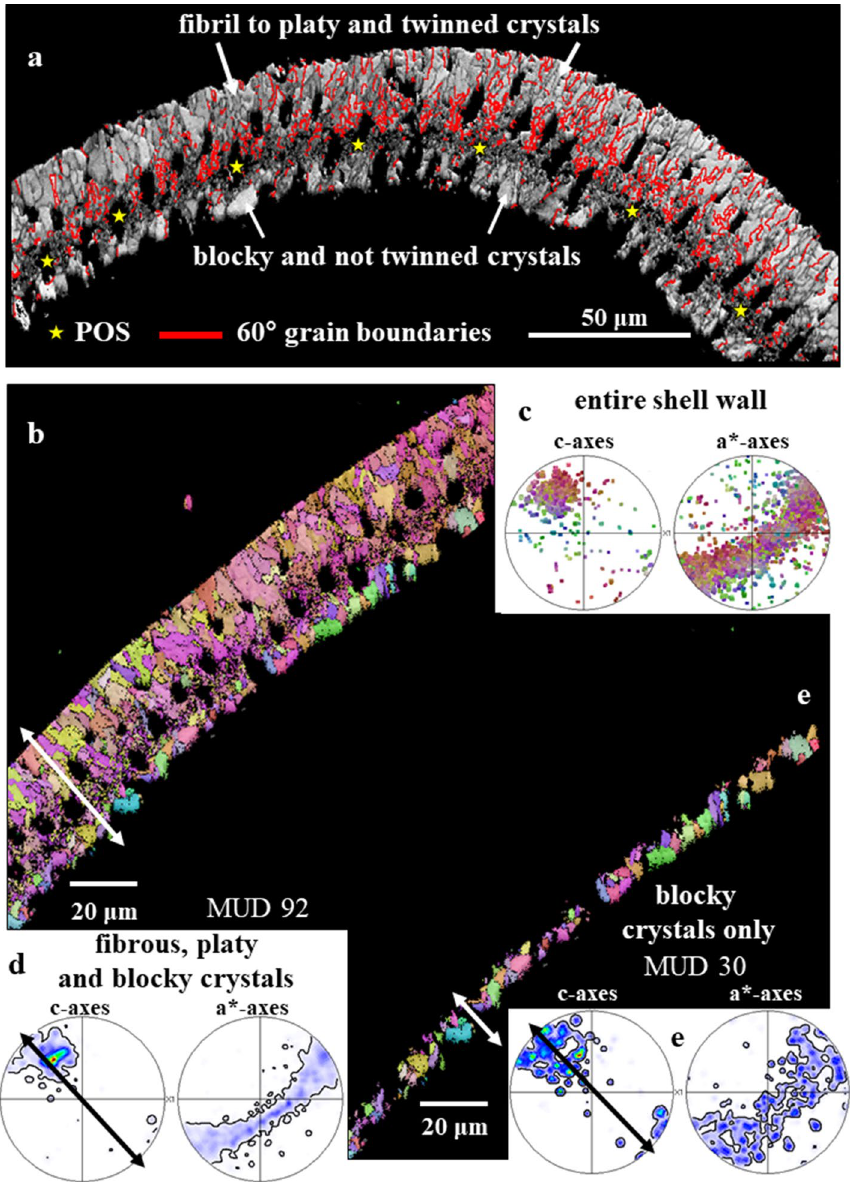
Figure 10. Structural characteristics of crystals and crystal assemblies on the two sides of the POS in Pulleniatina obliquiloculata shells. ( a ) EBSD band contrast measurement, with the distribution of 60° grain boundaries superimposed as red lines. ( b ) and ( e ) crystal orientation maps and ( d ) and ( f ) corresponding pole figures. Illustration of structural characteristics of the crystals and crystal units on the two sides of the POS: (1) fibril to platy crystal assemblages that are twinned ( b ) and (2) blocky, crystals that are not twinned ( e ). Blocky and fibril/fibrous-platy crystal assemblies have similar preferred orientation texture ( d , f ), they are, however, different in microstructure and crystal co-orientation strength. The blocky crystals are slightly less well co-oriented compared to the fibrous/platy crystals. Calcite c-axes are perpendicular to the shell surface for both the blocky as well as the fibril/platy crystal assemblages (white and black arrows in ( b ), ( d ), ( e ), ( f